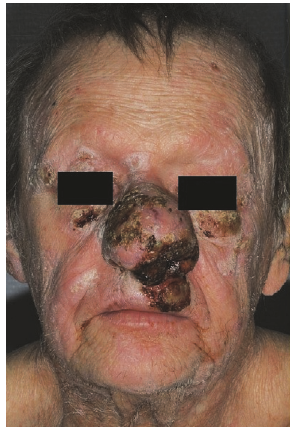
Figure 3: Aspect after radiotherapy (front view).